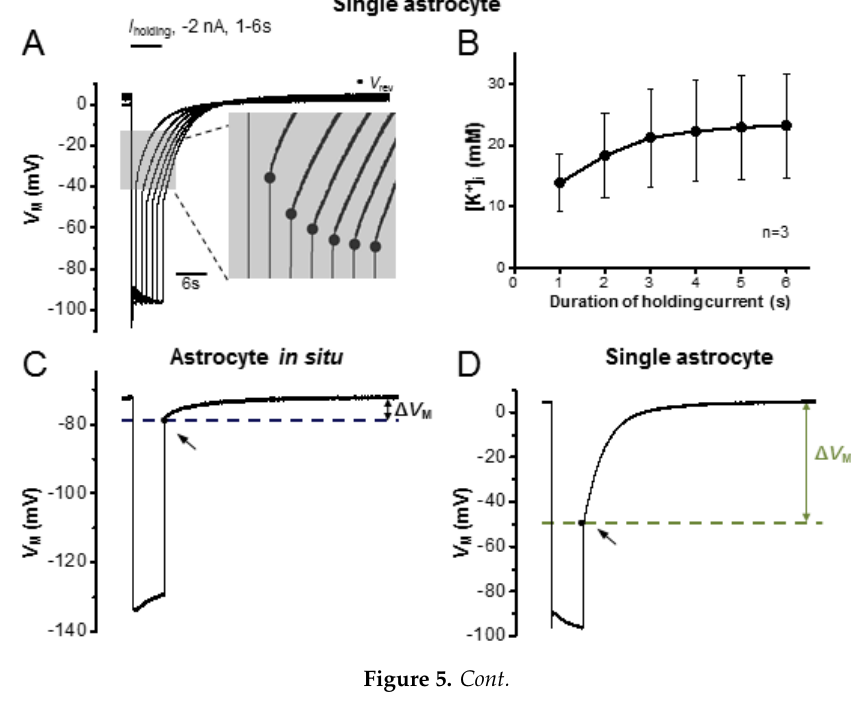
Figure 5. Figure 5. Cont.